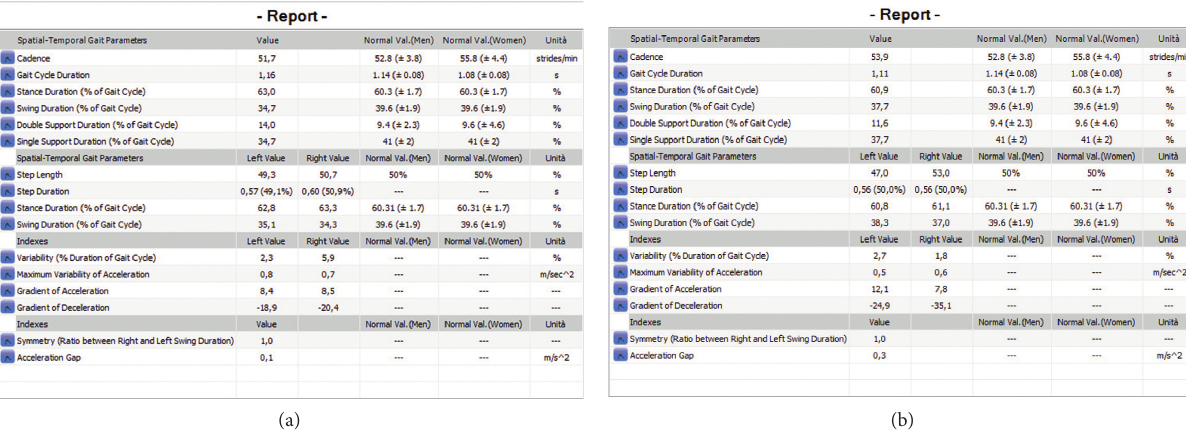
Figure 5: The exemplary result of a gait examination (a) before and (b) after a therapeutic